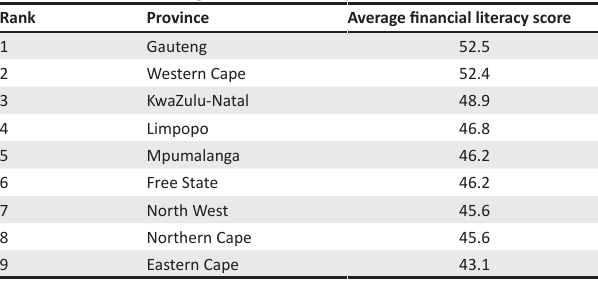
Note: The table shows the average financial literacy scores per province and their ranking as a result thereof. The data is weighted to be nationally representative, with weights benchmarked against Statistics South Africa weights.